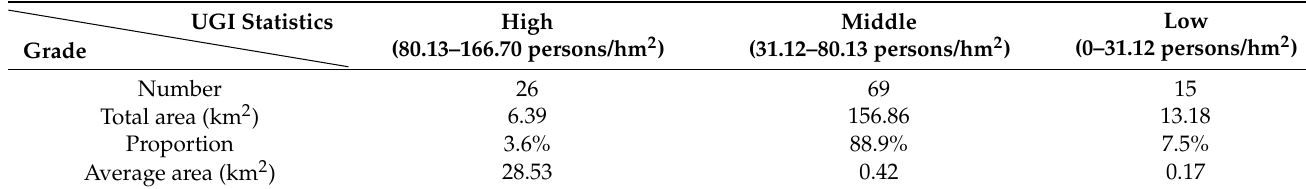
Table 11. UGI area and proportion of each public vitality